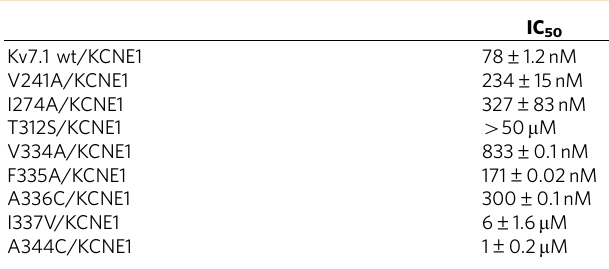
Table 1 | IC 50 values for AC-1 determined for